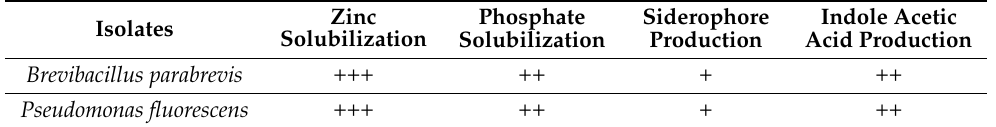
Table 4. Detection of zinc and phosphate solubilization and siderophore and indole acetic acid production by Brevibacillus parabrevis and Pseudomonas fluorescens isolates. Isolates Brevibacillus